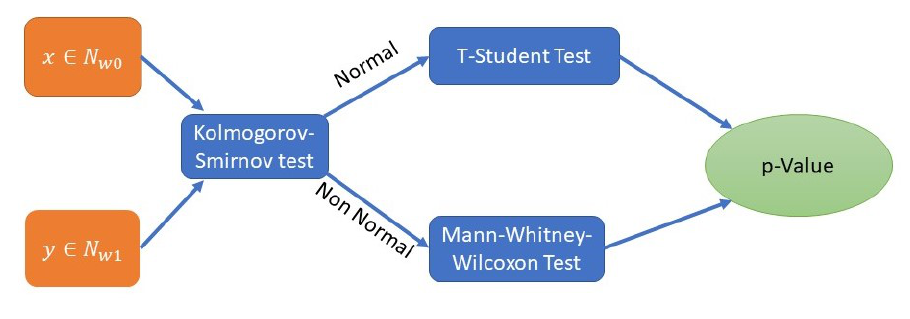
Figure 3. Calculation of p -Value in the Statistical Significance